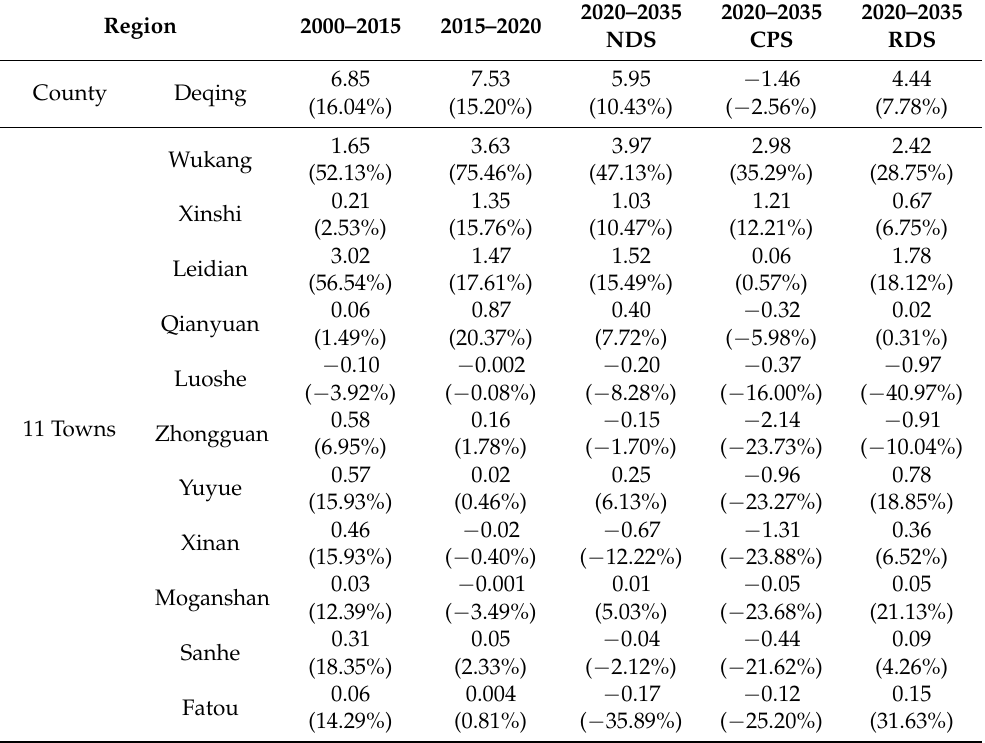
Table 7. Rural settlement change during 2000–2035 (NDS, CPS, and RDS) (km 2 , %).